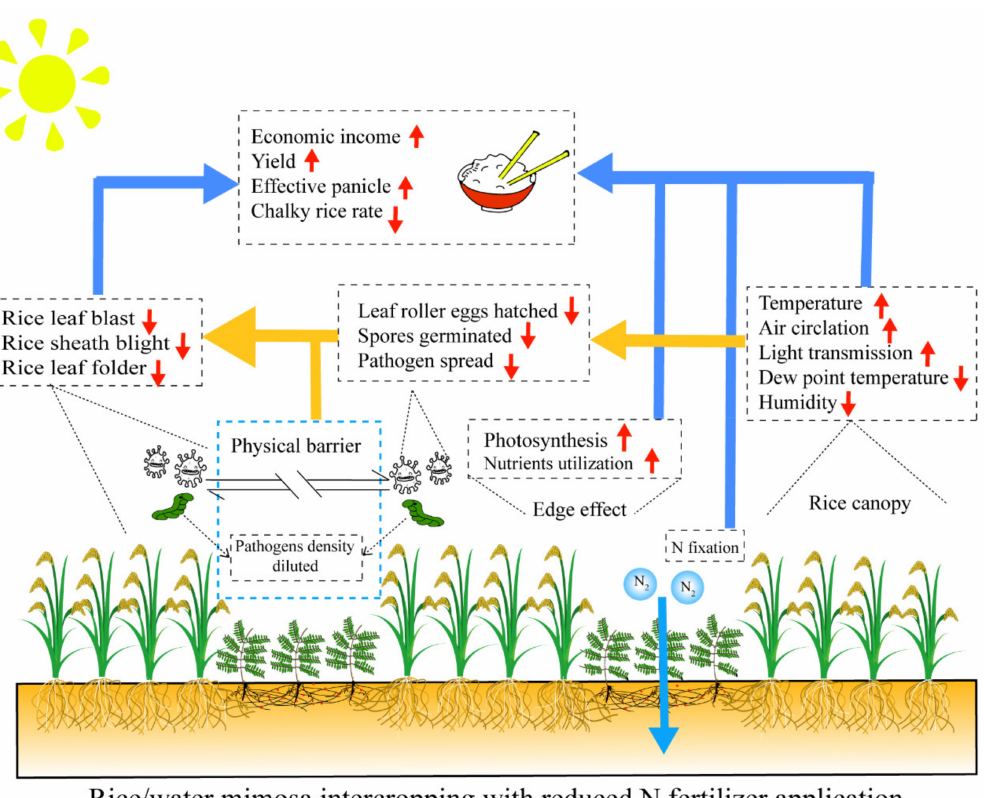
Figure 3. Mechanisms of rice/water mimosa intercropping with reduced N application to modify canopy microclimate of rice, control pest and disease, and improve rice yield, grain quality, and economic